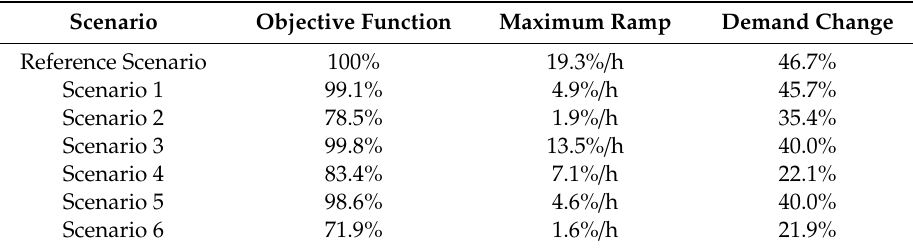
Table 4. Summary of the results.